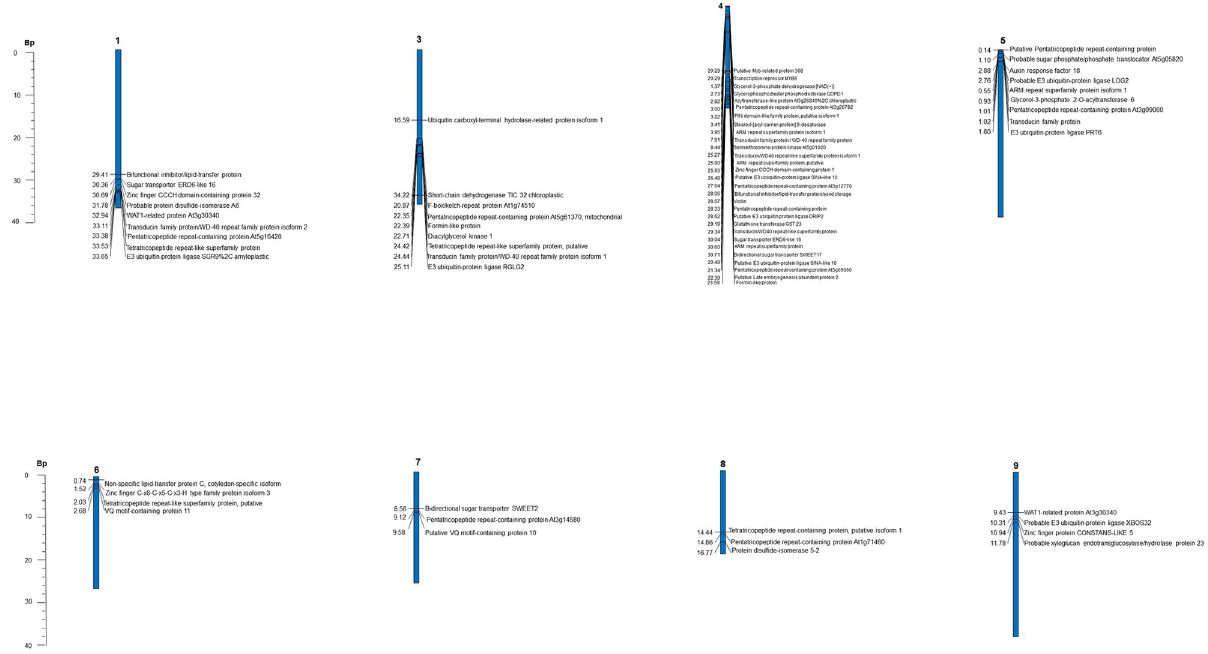
Fig 7. Physical map of T . cacao L. showing annotated candidate genes, which were co-localised with SNP markers associated with yield-related and other traits. Gene loci and proteins are shown on the right and genetic distances (Mb) are shown on the left. No candidate genes were identified on chromosomes 2 and